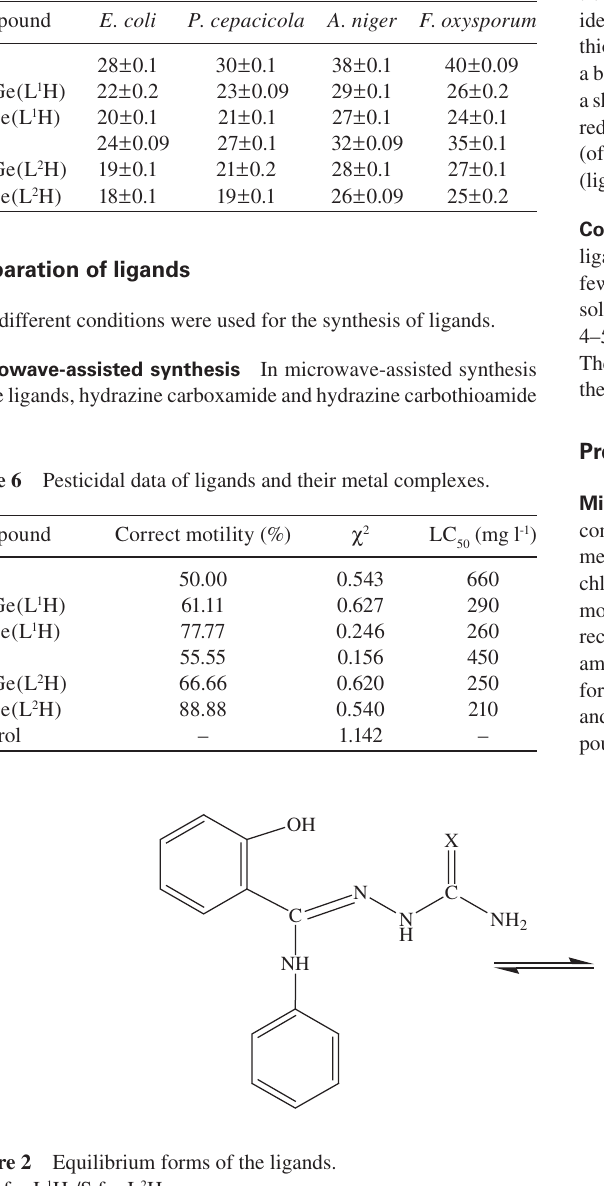
Table 5 MIC (mg ml -1 ) of ligands and their complexes. Compound